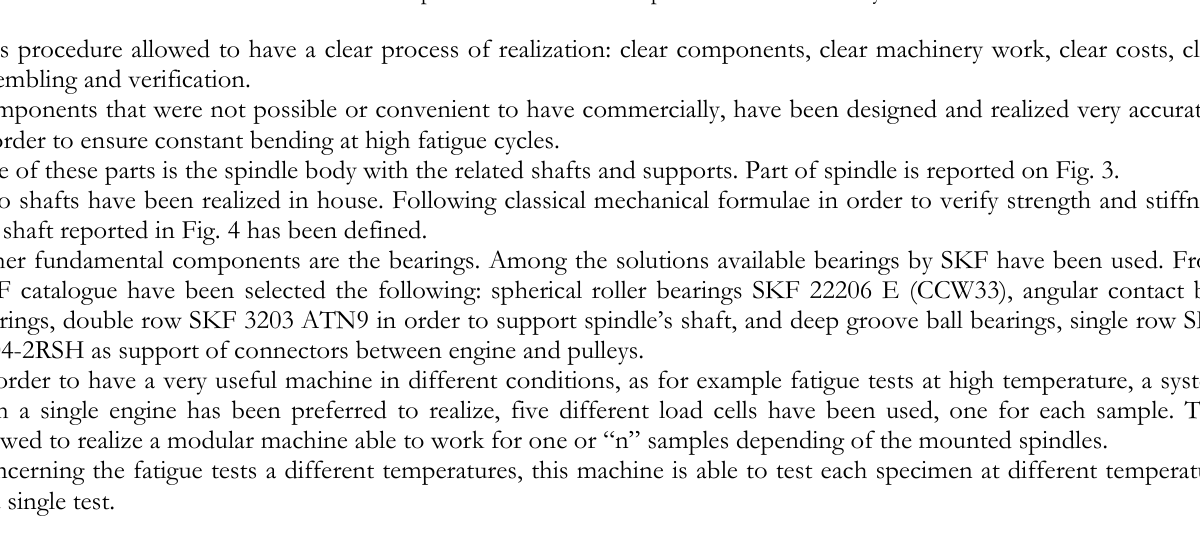
Table 2: Example of the work sheet implemented for cost